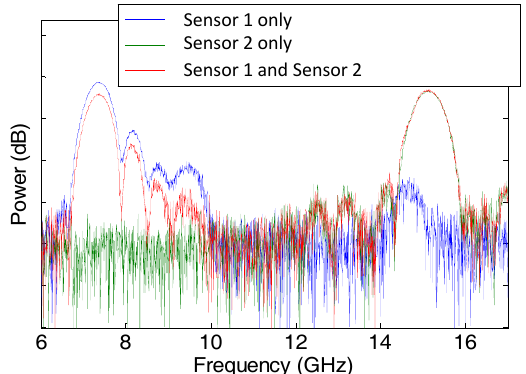
Figure 5. Measured MWP filter responses from Sensor 1 only, Sensor 2 only, and from both sensors simultaneously (after Reference [12]).